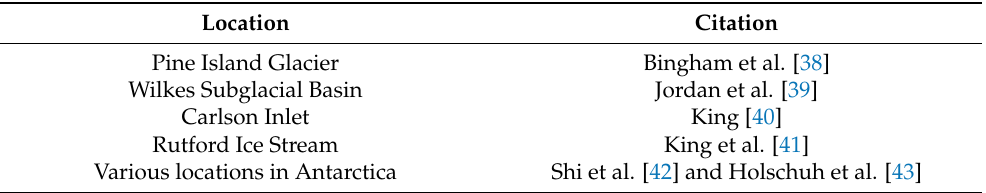
Table 1. High-resolution ground-truth datasets from ice-penetrating-radar surveys used to train the MB_DeepBedMap model